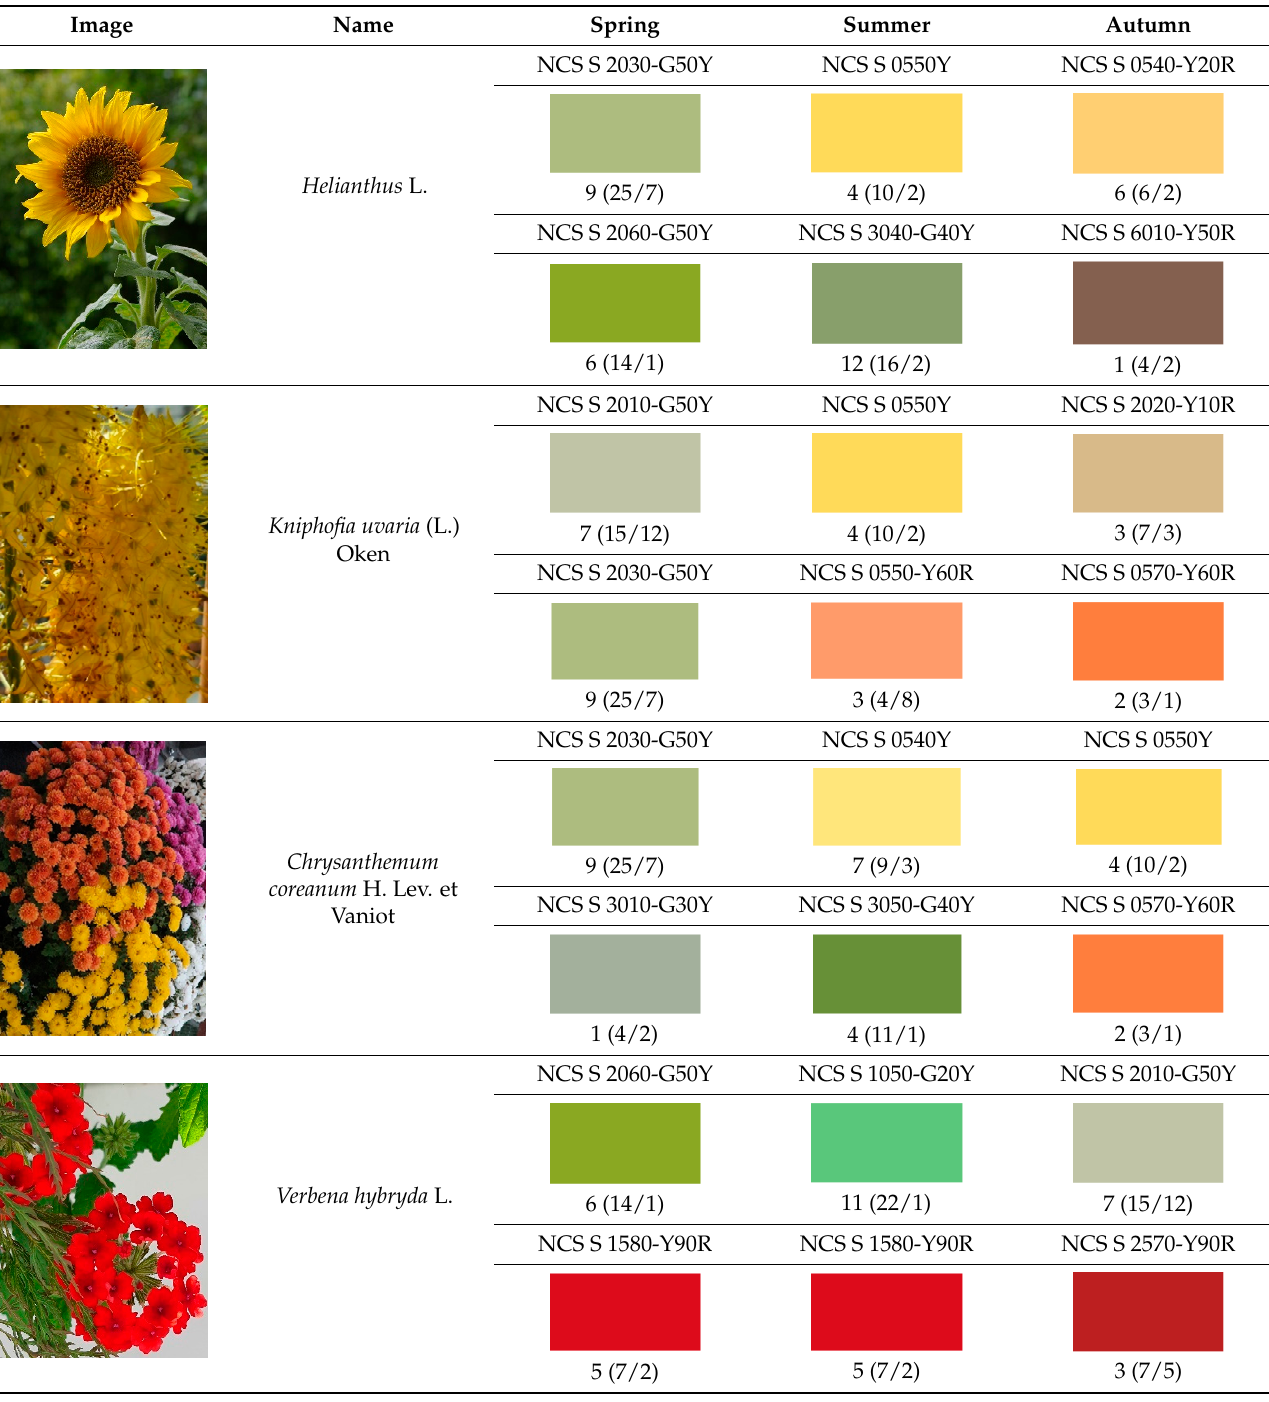
Table A3. One hundred and twenty-three color samples taken from the blooming plants identified in the research area. The numbers below the color sample provide the information how many times a given color appears in the table (how many times it appears in all natural samples/how many times it appears in the analyzed architectural